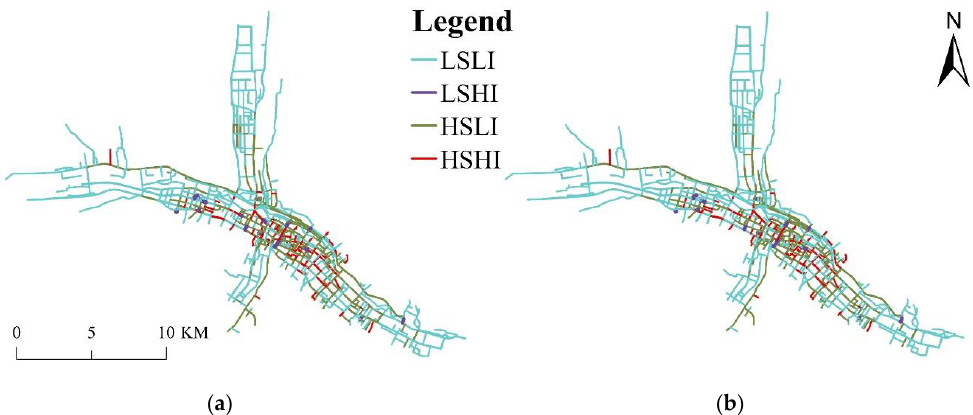
Figure 7. Spatial distribution of street vitality types. ( a ) Weekdays; ( b ) Weekends. “LSLI” represents streets with low- stability and low-intensity vitality; “LSHI” is an abbreviation for streets with low-stability and high-intensity vitality; “HSLI” describes the streets with high-stability and low-intensity vitality, and “HSHI” symbolizes the streets with high-stability and high-intensity vitality.